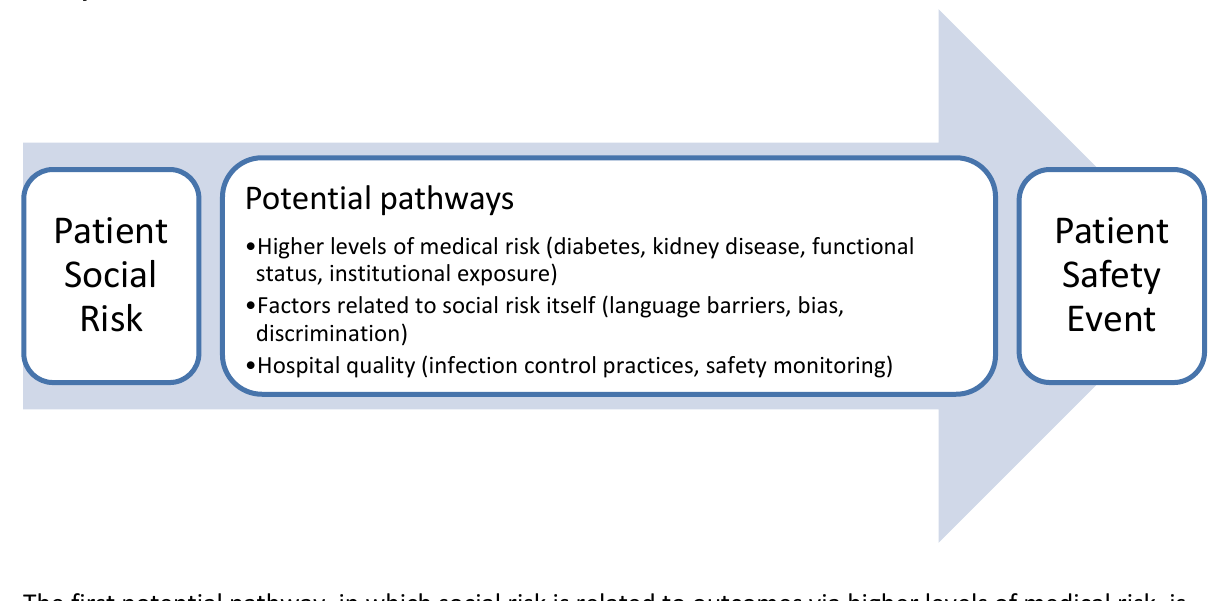
Figure 6.1 Conceptual model of relationship between beneficiary social risk and risk of inpatient safety events or healthcare associated